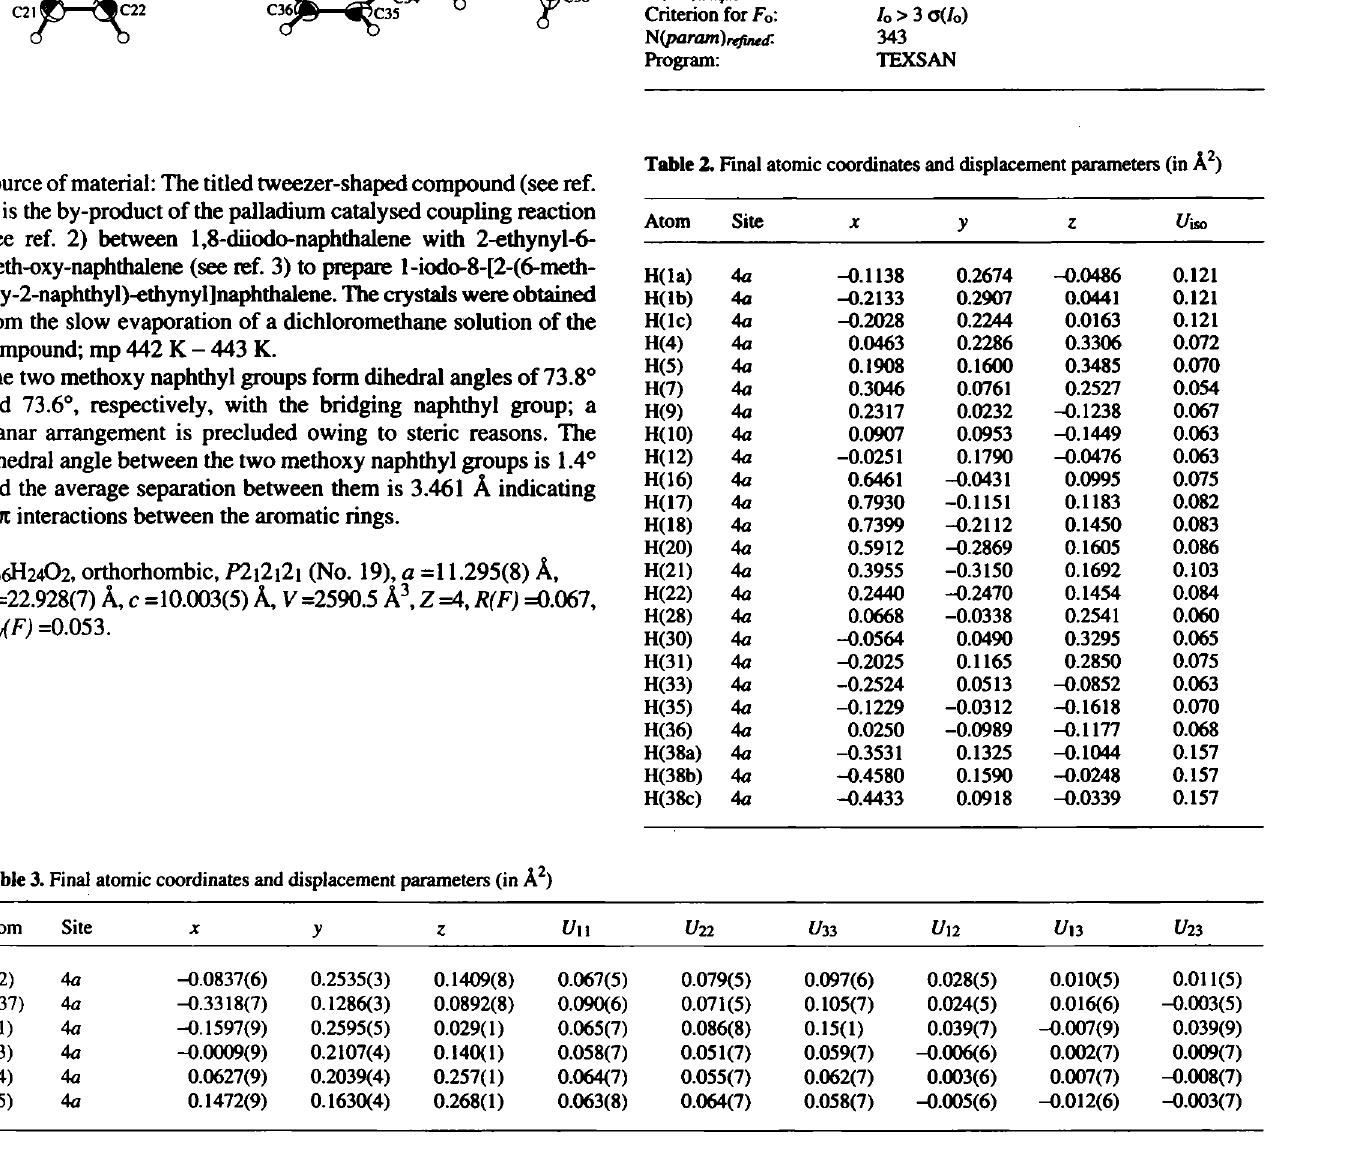
Table 1. Parameters used for the X-ray data collection Ciystal: